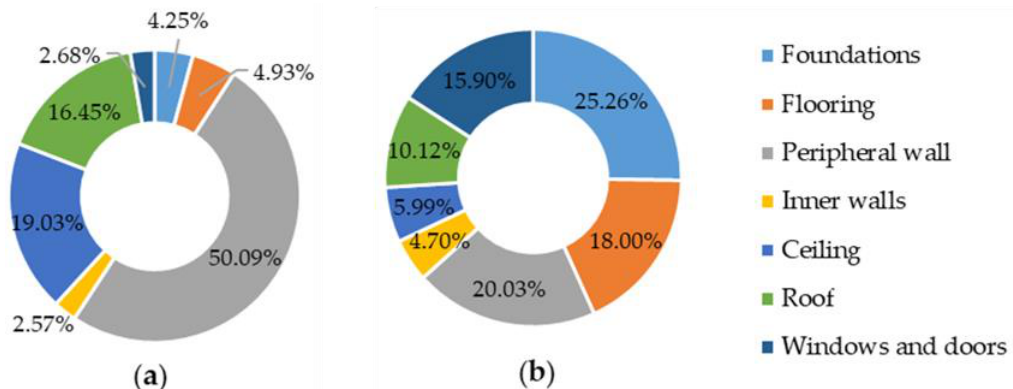
Figure 11. Impact distribution of construction components on abiotic depletion: ( a ) depletion of elements; ( b ) depletion of fossil fuels.